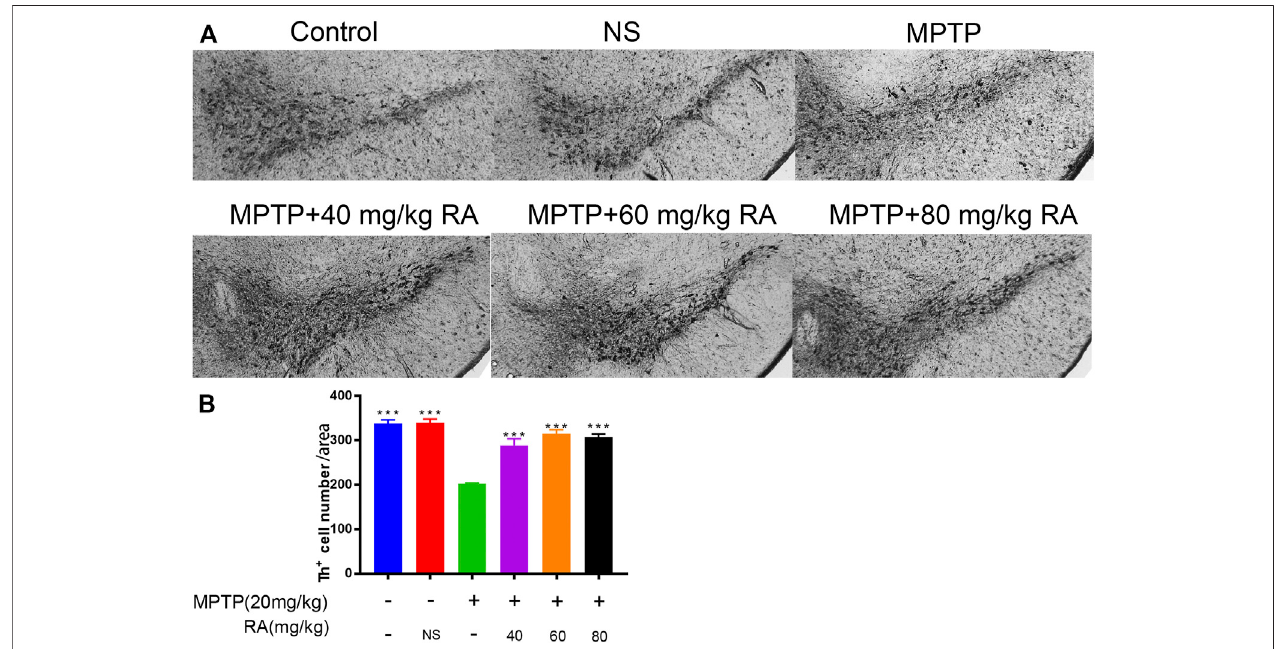
FIGURE2| RApreventedthedopaminergicneuronallossintheSNofPDmice.Comparedwiththecontrol,MPTPinduced55.7%ofdopaminergicneuronallossin the SN, and this loss was improved by preinjecting with 40 mg/kg RA (induced 7.80%), 60 mg/kg RA (induced 8.30%), and 80 mg/kg RA (induced 6.80%) (A,B) . Data areexpressedasmean±SD.One-wayanalysisofANOVAwithTukey ’ stestwasused.N=3micepergroup,* p < 0.05,** p < 0.01,*** p < 0.001whencomparedwiththe MPTP